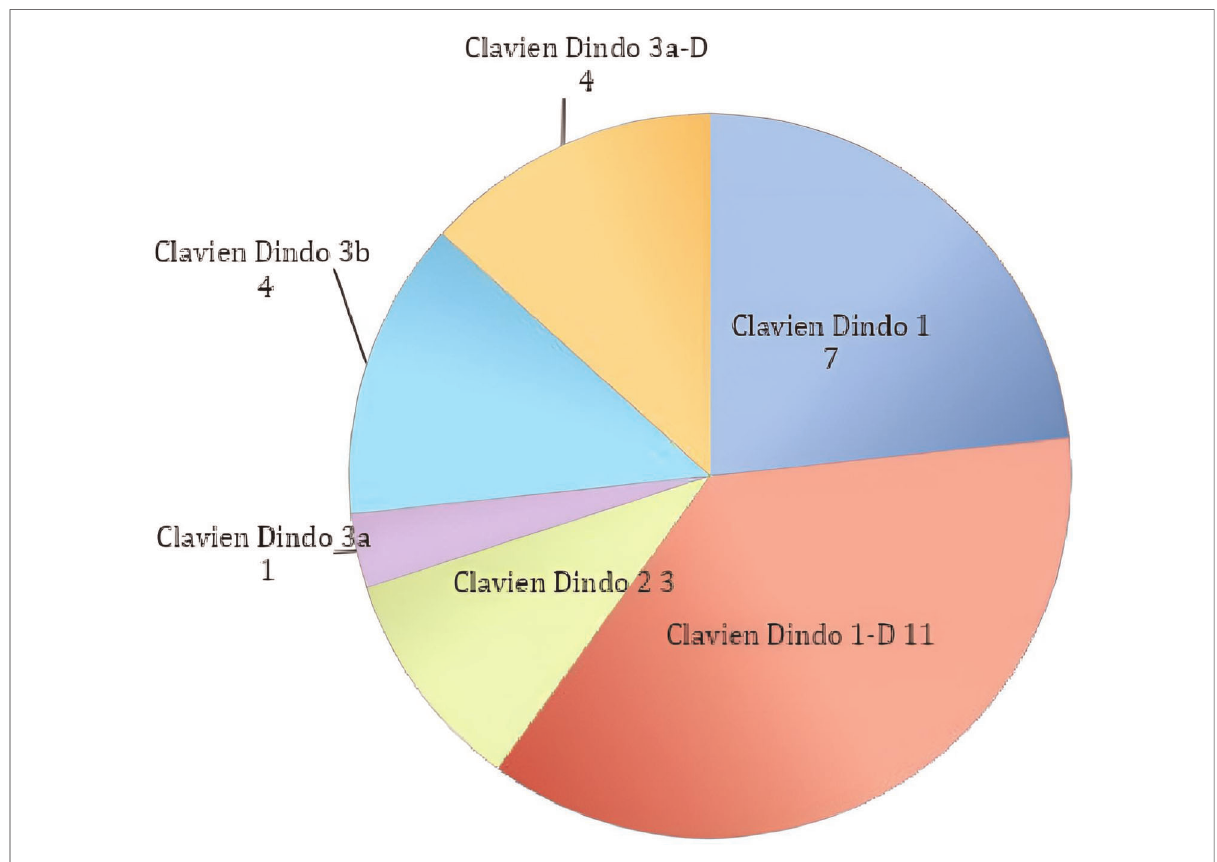
FIGURE 3 Complication sub-classi fi cation of group